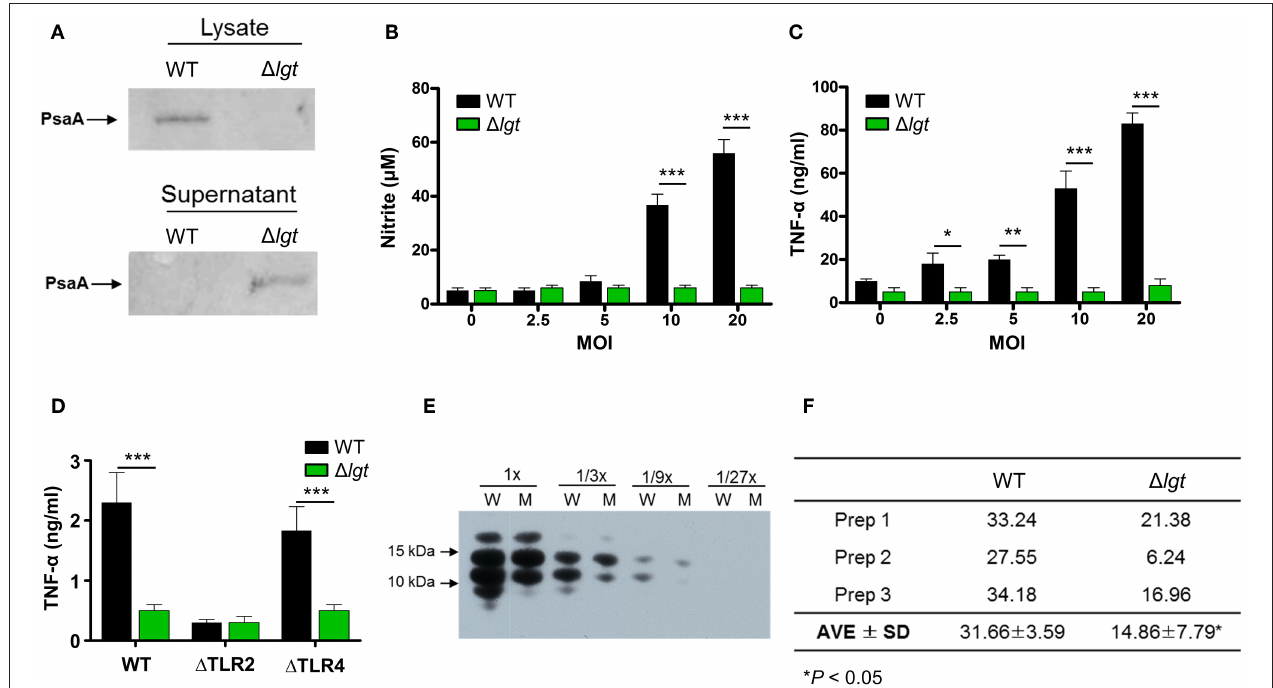
FIGURE 1 | Biochemical and Immunological Characteristics of TIGR4 1 lgt. (A) Expression of PsaA protein in cell lysates and culture supernatants from wild-type (WT) and lgt -deficient ( 1 lgt ) TIGR4 strains. (B,C) Nitric oxide (B) and TNF- α (C) production in culture supernatants of RAW264.7 cells treated with WT or 1 lgt strain for 12h. (D) TNF- α production in the culture supernatants of peritoneal cells from wild-type (WT), TLR2-deficient ( 1 TLR2), and TLR4-deficient ( 1 TLR4) mice infected with WT or 1 lgt strain for 12h. Data in (B,C) , and (D) represent mean values ± S.D. of triplicate results. * P < 0.05, ** P < 0.01, and *** P < 0.001 compared to the WT treatment group. (E) LTA expression levels in 3-fold serial dilutions of culture supernatants from WT (W) or 1 lgt (M) strains. (F) Quantification of LTA isolated from the pellets of WT and 1 lgt strains. * P < 0.05 compared to the WT